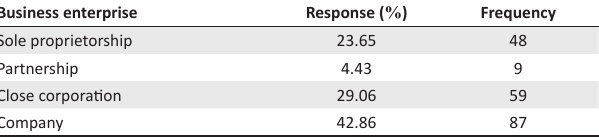
TABLE 1: Percentage response and frequency of forms of enterprise ( N = 203).